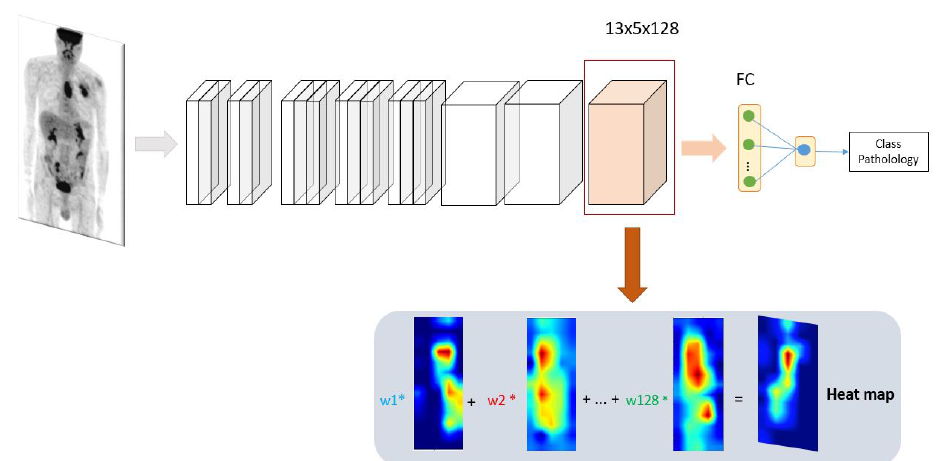
Figure 4. Heatmap generation using convolutional neural network. The MIP is used to predict the pathology. A heat map is generated from the last convolutional layer. The heat map allows to highlight class-specific regions of the